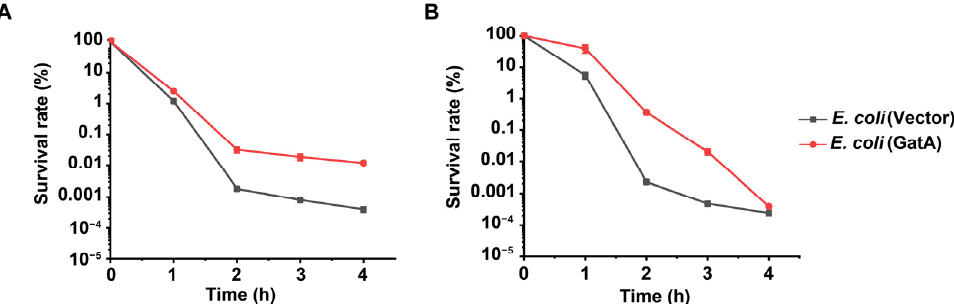
Figure 6. Cell viability of recombinant strains under different organic acid lethal stress conditions with incubation time. ( A ) Recombinant strains incubated under itaconic acid lethal stress. ( B ) Re- combinant strain incubated in succinic acid lethal